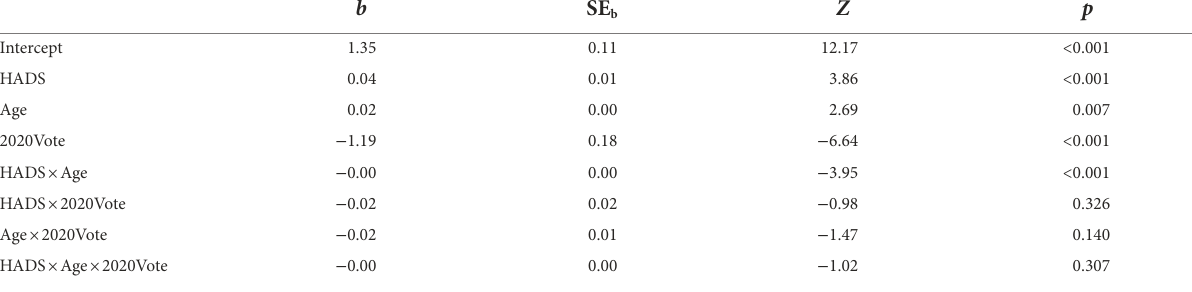
TABLE 6 Logistic regression analysis of vaccinated vs. unvaccinated with age, distress, and political preference as independent variables. b SE